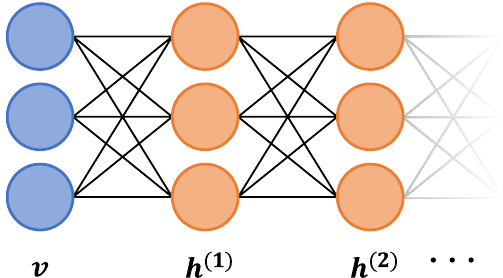
Figure 1. Schematic of a deep Boltzmann Machine with a visible layer, v , and hidden layers, h ( j ) , with j = 1, 2, . . . . Connections between nodes are symmetric and undirected, in contrast to typical directed feedforward